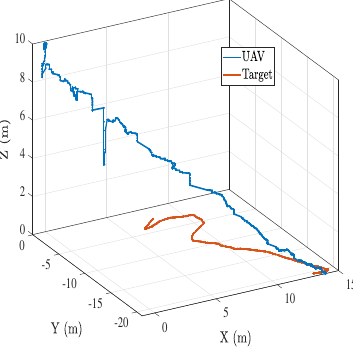
Figure 15. Case1: ( a ) UAV-target trajectory for a nonstraight-line moving target landing; ( b ) lateral velocity profile of UAV ( a , b , c ) = ( 40,130, − 161 ) ; ( c ) longitudinal velocity profile of UAV ( a , b , c ) = ( 40,130, − 161 ) ( d ) z velocity profile of the UAV ( a , b ) = ( 6,3 ) .